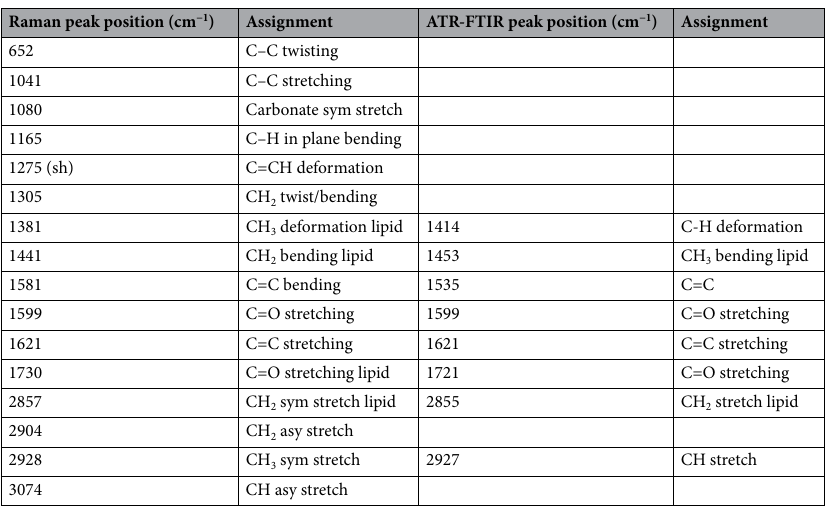
Table 1. Raman and ATR-FTIR vibrational modes assignment for fish fossil. sh: Shoulder, sym: symmetric, asy: asymmetric.